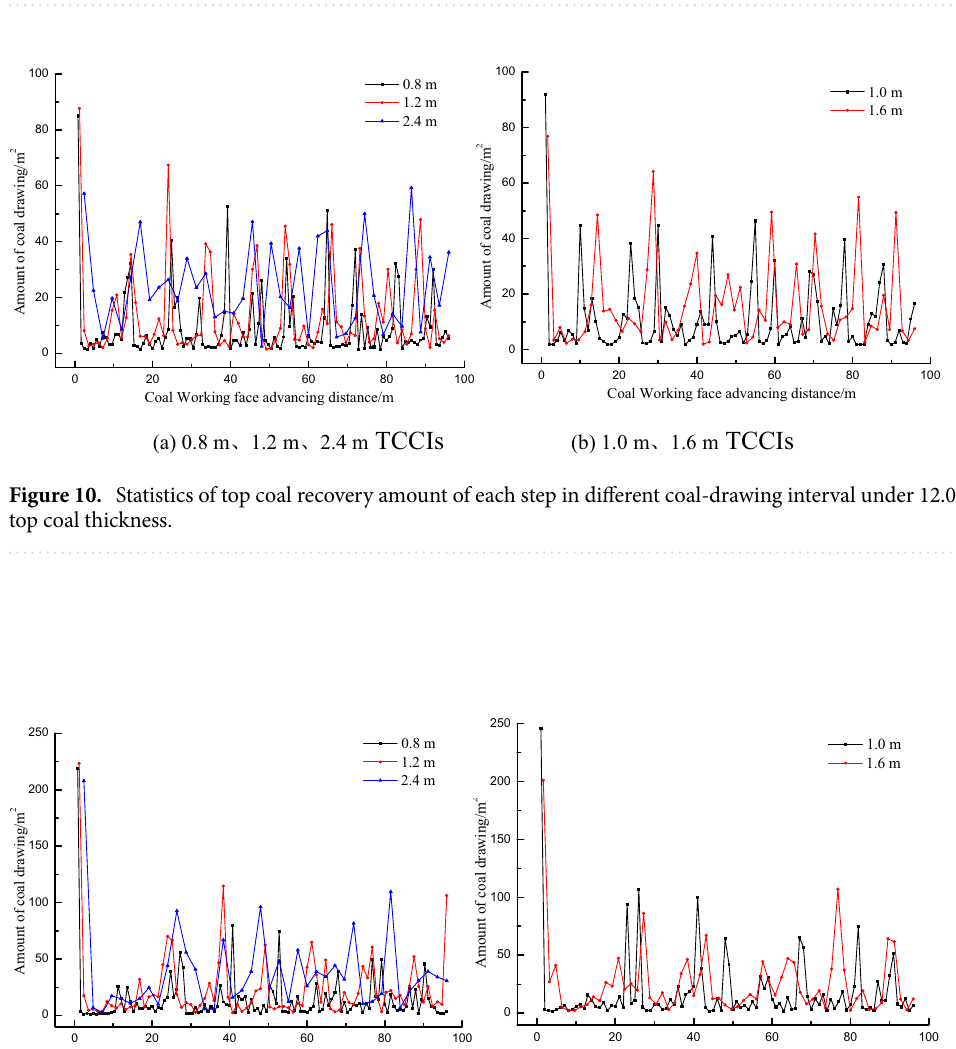
Figure 9. Statistics of top coal recovery amount of each step in different coal-drawing interval under 4.0 m top coal thickness.